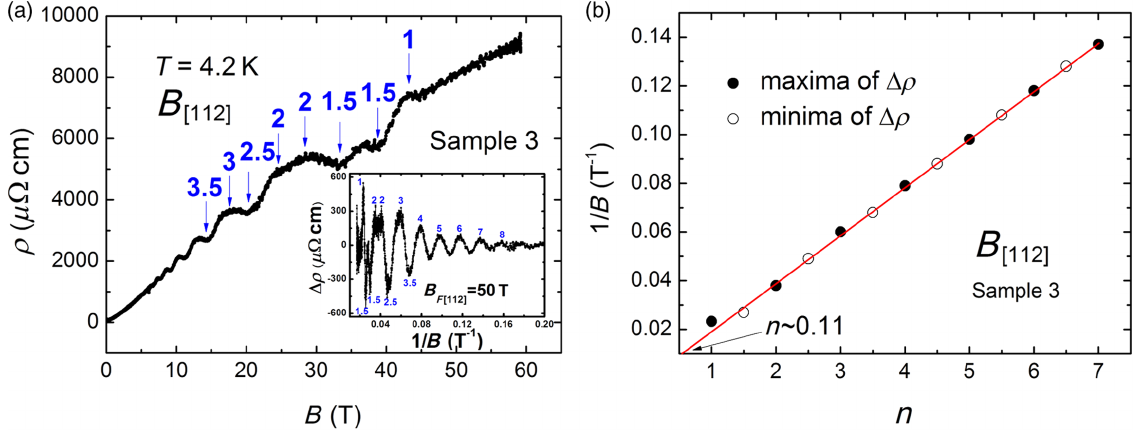
FIG. 6. High magnetic field transport measurement of Sample 3 up to 60 T. (a) Magnetoresistivity measured in the perpendicular field B ½ 112 (cid:2) at different temperatures at T ¼ 4 . 2 K up to 60 T. Zeeman splitting features can be observed at higher magnetic field. Inset shows the SdH oscillations after subtracting the polynomial background. (b) Landau level index plot. The n ¼ 1 Landau Level is reached at B ¼ 43 T. Quantum linear magnetoresistance is observed at the field higher than 43